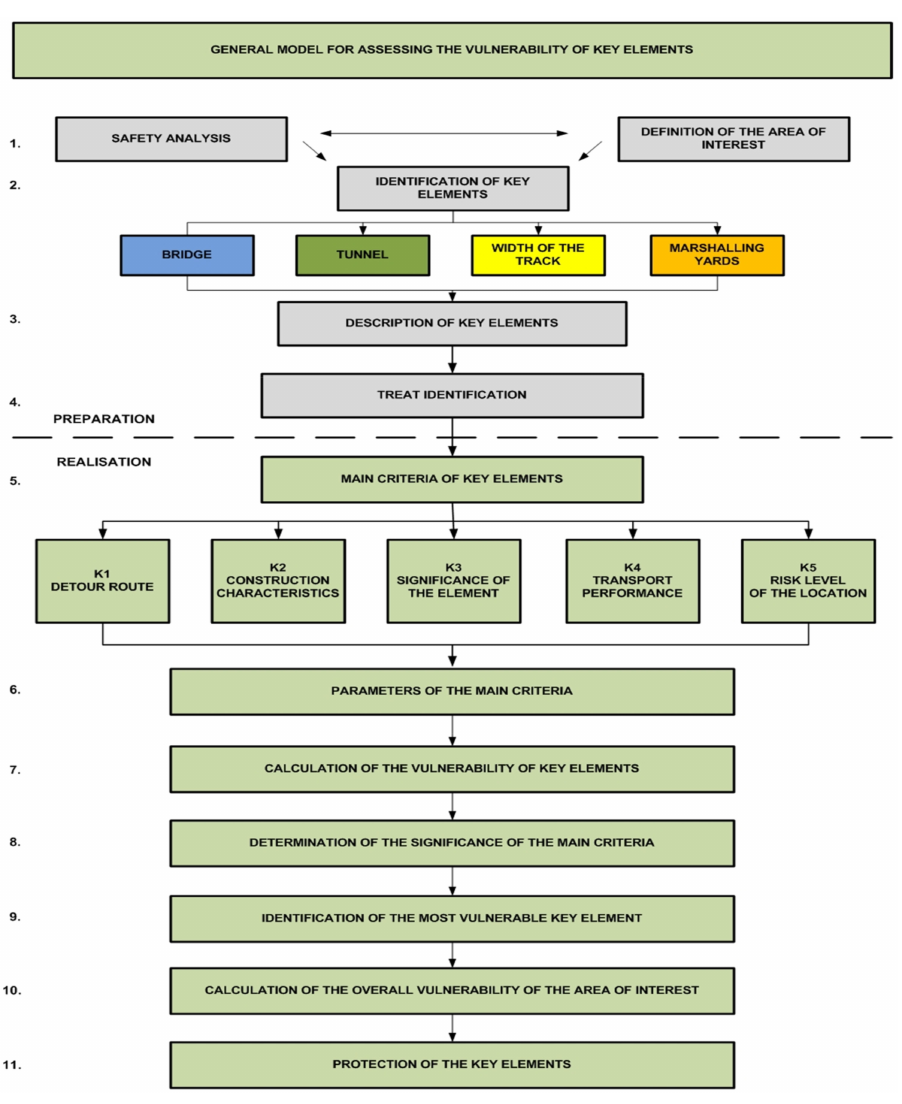
Figure 3. A general model for calculating the vulnerability assessment of key